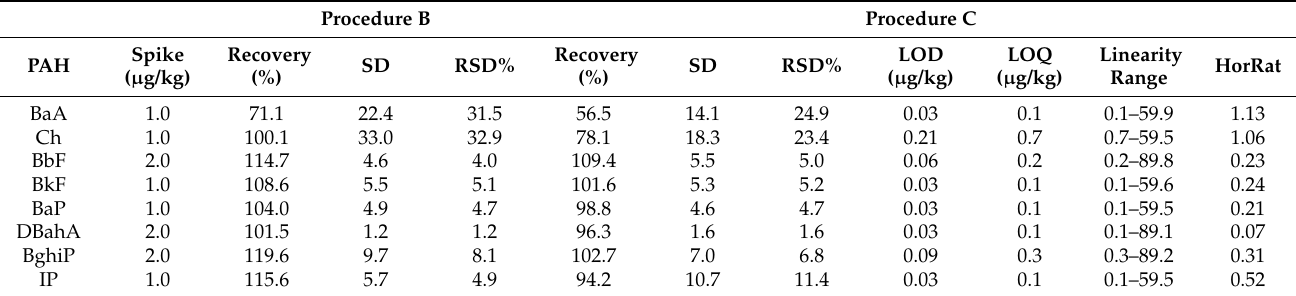
Table 2. Mean percentage recoveries, standard deviations (SD), and relative standard deviations (RSD%) obtained by applying the new proposed purification approach (Procedure C) and the method proposed by Moreda et al. [35] (Procedure B) on a spiked crude pomace oil sample ( n =